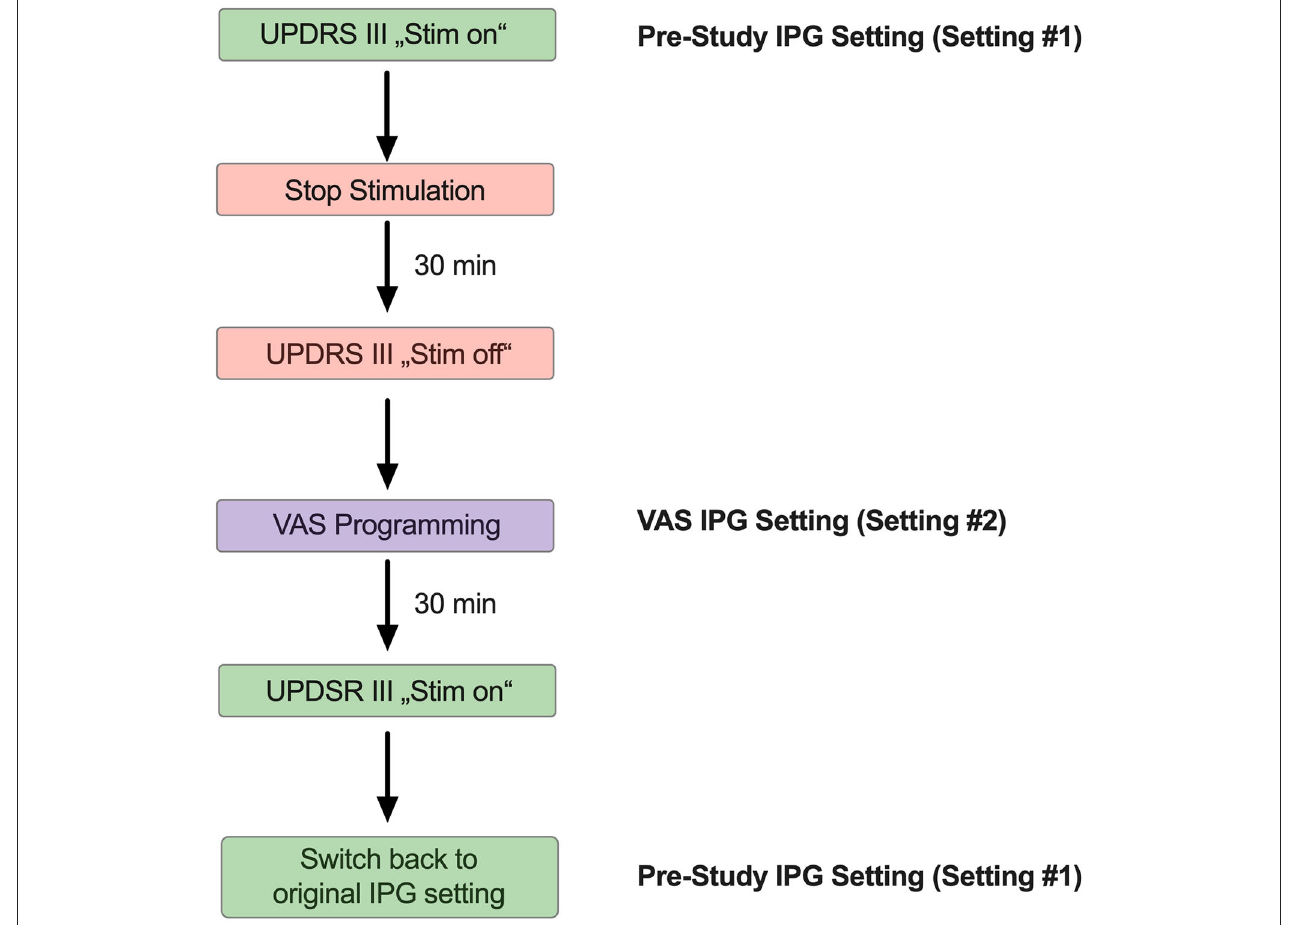
FIGURE 1 | Schematic illustrating the sequential adjustment of the IPG setting during the study visit. Each study participant participated in one single study visit. At the beginning of the study visit, a UPDRS III was obtained with the stimulator switched on (“Stim on”). Next, the IPG has been switched of and the study subjects were asked to rest for 30min, followed by another UPDRS III (“Stim off”). Thereafter, the study participants were subjected to VAS-based IPG programming. After another 30min, a final UPDRS III has been obtained from all study subjects with the VAS-derived DBS program activated (“Stim on”). At the end of the study visit, all participants were switched back to the original